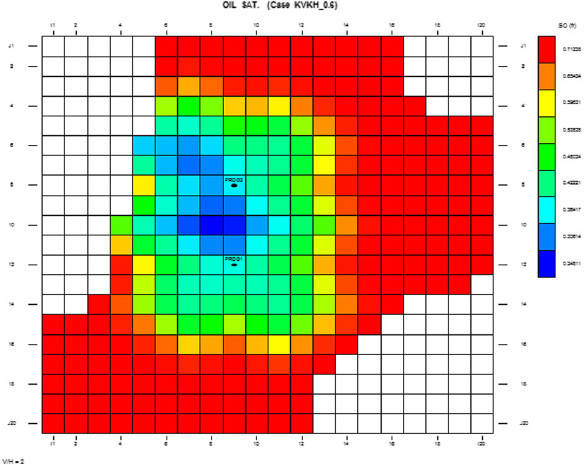
Fig. 15 2D Map showing the distribution of oil saturation across zone 3 of the reservoir X and the location of producers (PROD 1 and PROD 2) at the end of simulation (blank cells represent non-reservoir grid cells)